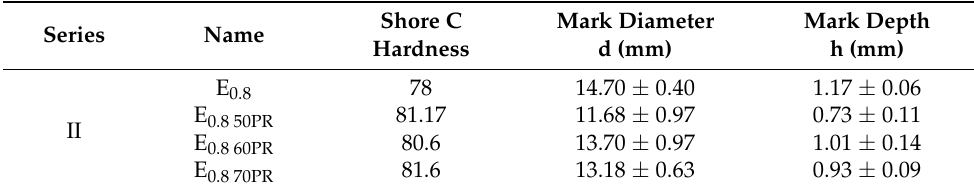
Table 2. Shock-impact resistance (UNE-EN 520).